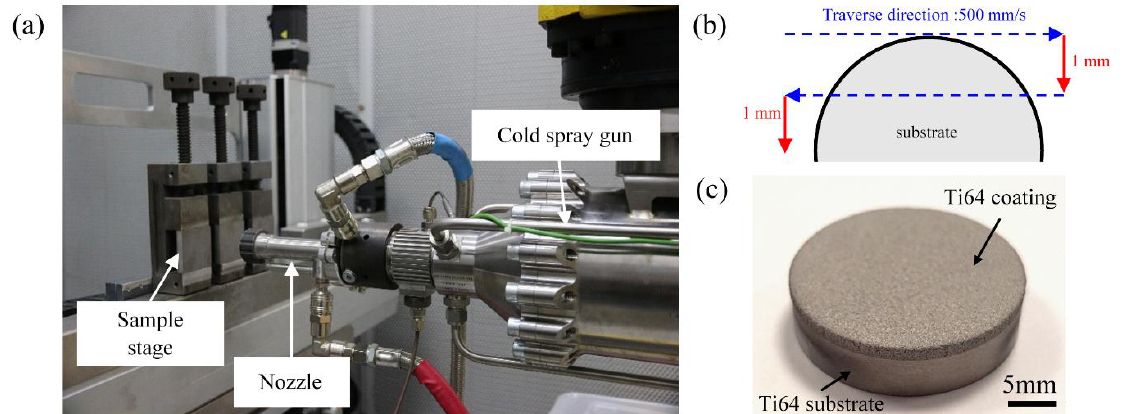
Figure 2. ( a ) Cold-spray setup (shown in previous work [53]); ( b ) illustration of nozzle’s scanning path and ( c ) photograph of a cold-sprayed Ti64